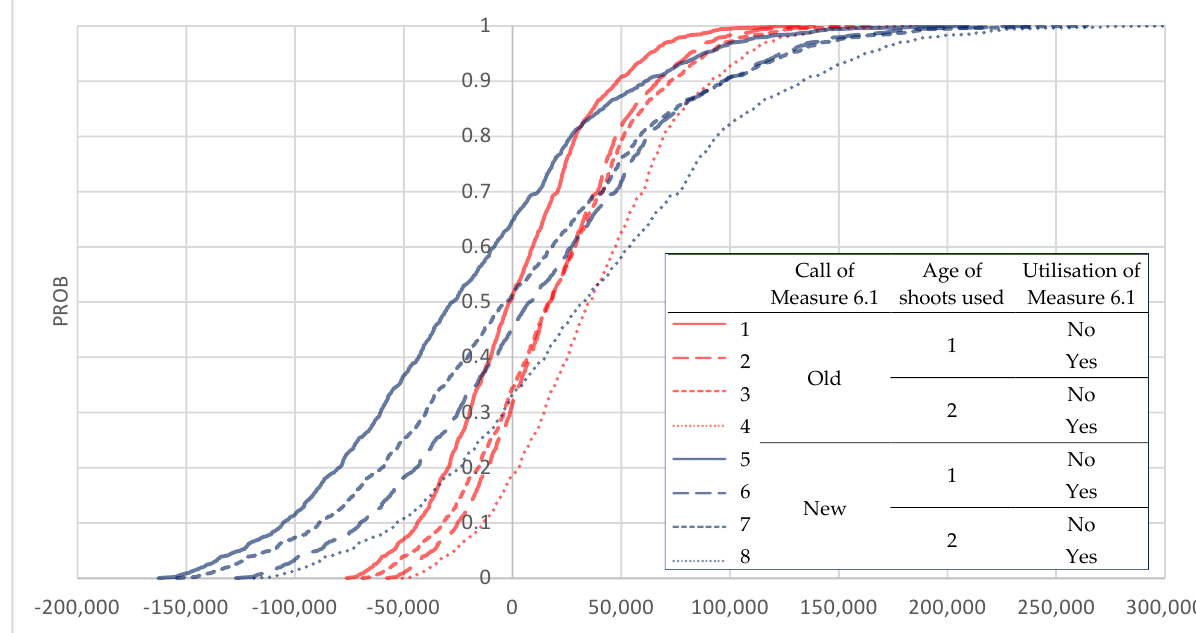
Figure 7. NPV distribution under the alternative scenarios (source: own elaboration).